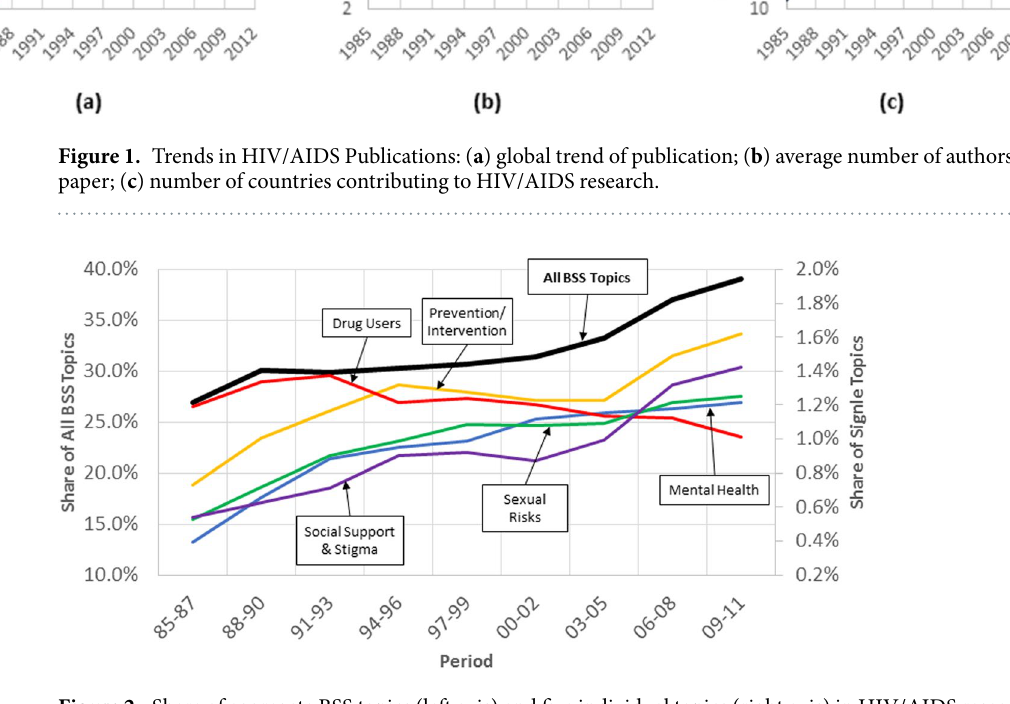
Figure 2. Share of aggregate BSS topics (left axis) and five individual topics (right axis) in HIV/AIDS research over